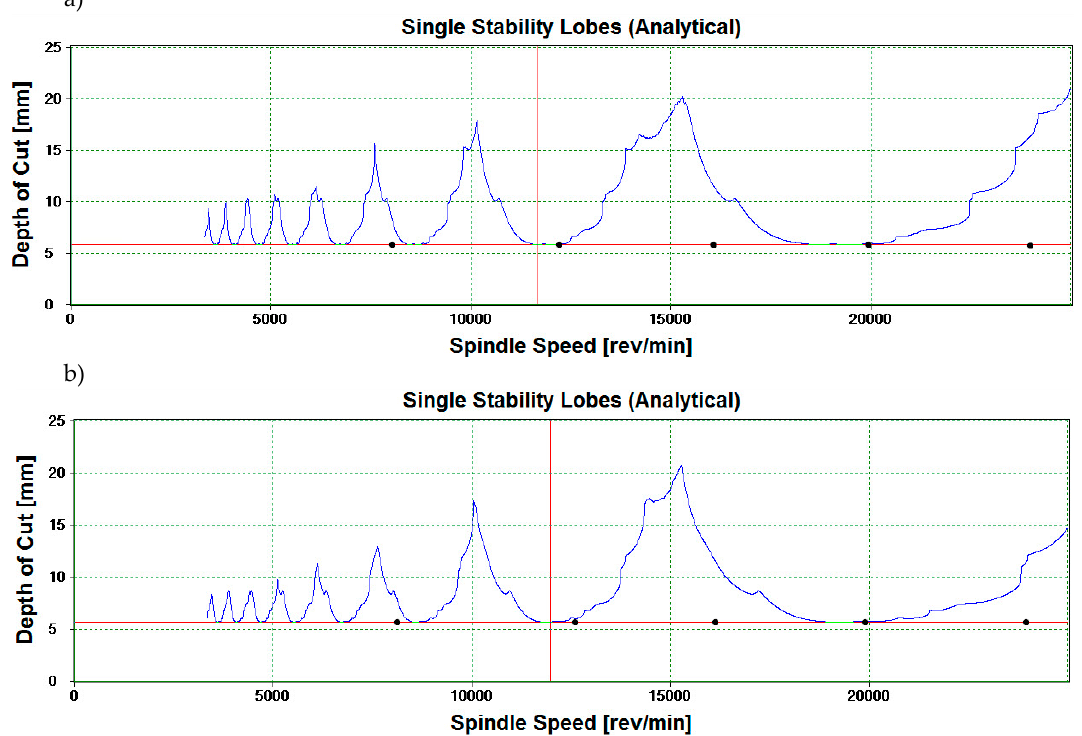
Figure 3. Stability lobes diagrams for ( a ) AZ31 and ( b ) AZ91D magnesium alloys